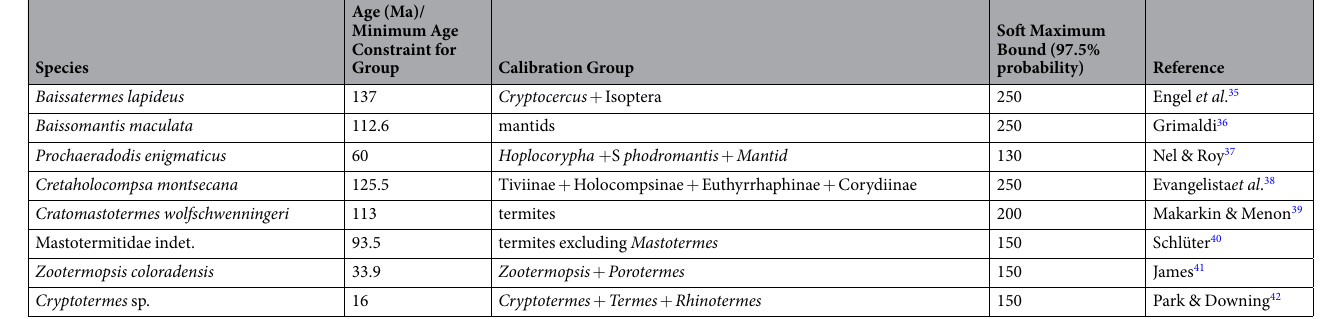
Table 2. Fossils Used for Estimation of Divergence Time of Major Clades in the Analysis of Blattodea with 26 outgroup